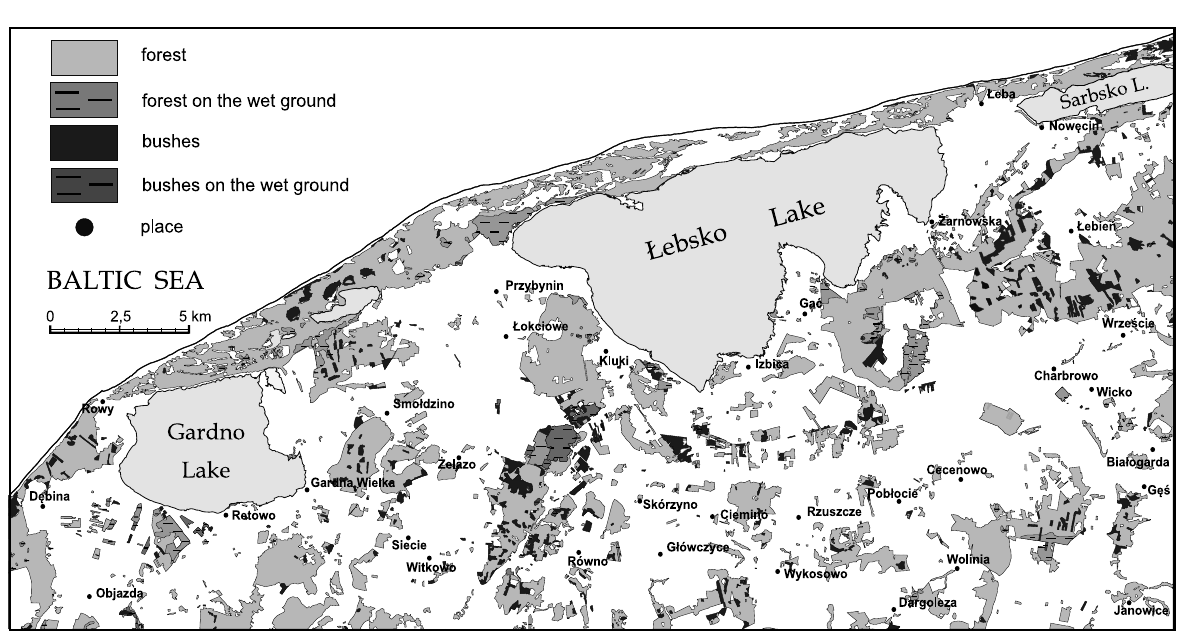
Fig. 10. Extent of forests in Gardno-Łeba Lowland in the second half of 20th